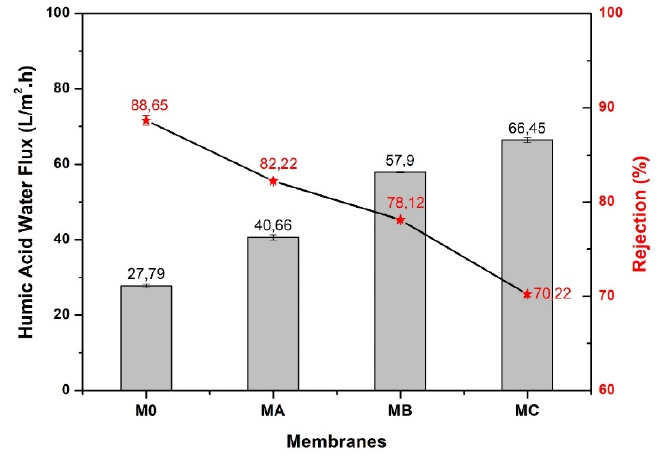
Figure 9. Water permeability and rejection of HA solution.